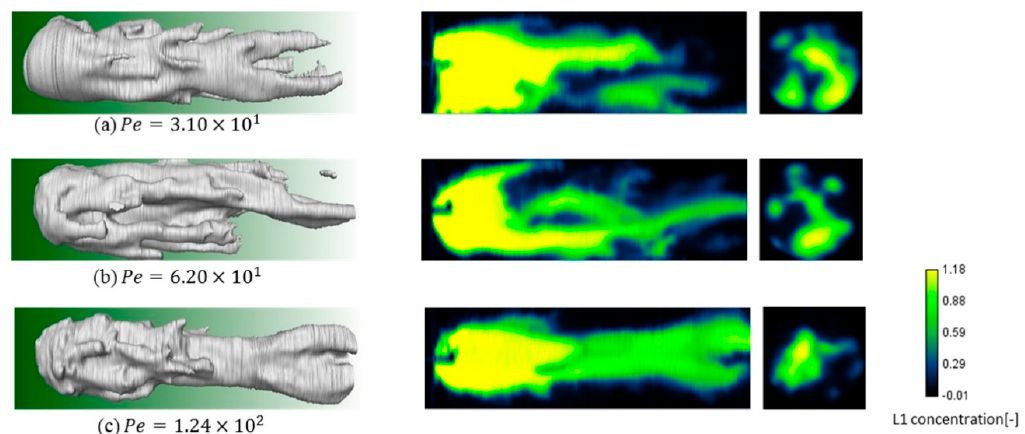
Figure 3. Left: Structure of fingering patterns at the LVF injection of 0.3 PV without density difference. Iso-contour surfaces corresponding to a 20 vol.% concentration of LVF were visible Center: Concentration of LVF in a vertical cross-section through the axis of the cylinder. Right: Concentration of LVF in a vertical cross-section at the center, between the inlet and the outlet.